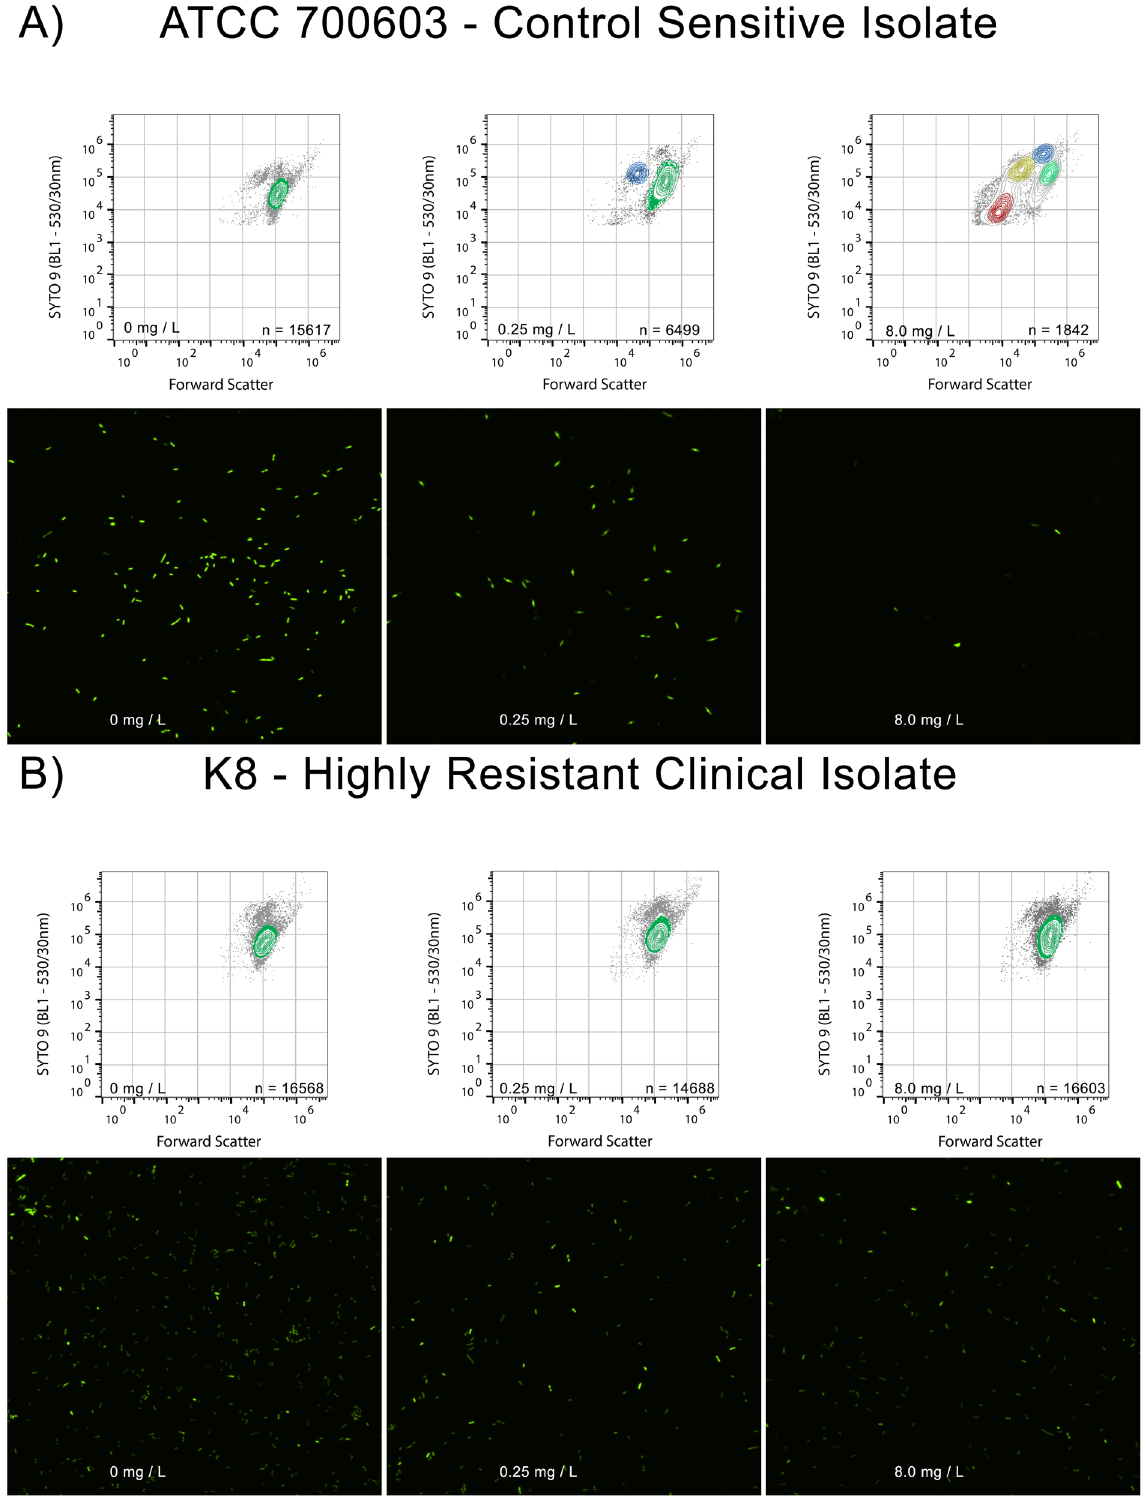
Figure 2. Standardised gating applied to raw data. ( A ) Collected events were gated to include only those with a SYTO ® 9 (BL1 - 530/30 nm) fluorescence of 10 4 arbitrary fluorescence units or higher. Doublets were removed via a FSC-A vs FSC-H plot. Background was removed by plotting specific SYTO ® 9 fluorescence (BL1 – 530/30) against an unused channel (BL3 – 640 LP). ( B ) In the antibiotic unexposed sample, 10% nearest-neighbour contouring was applied, and a gate (referred to as Unexposed Cell Morphotype) was set to include all clustered events. This gate was then applied to all samples across the antibiotic dilution